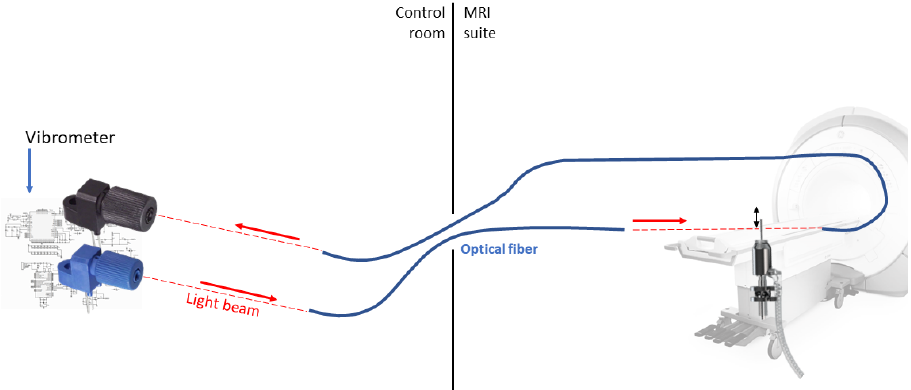
Figure 1. Schematic overview of the vibrometer (showing the different hardware components described above).